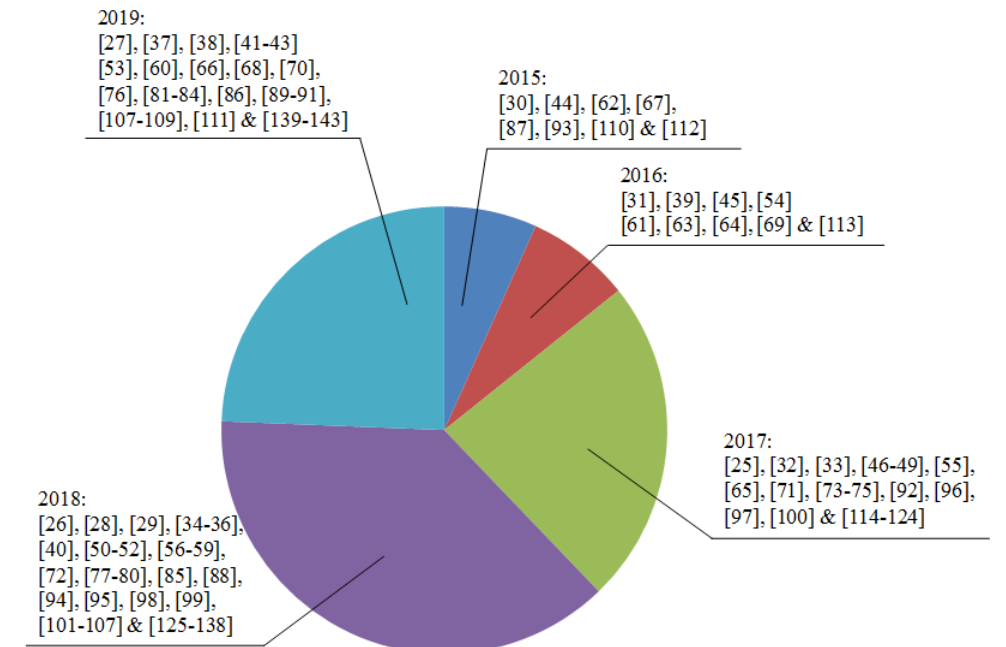
Figure 4. Categories of reviewed papers according to years of publication.